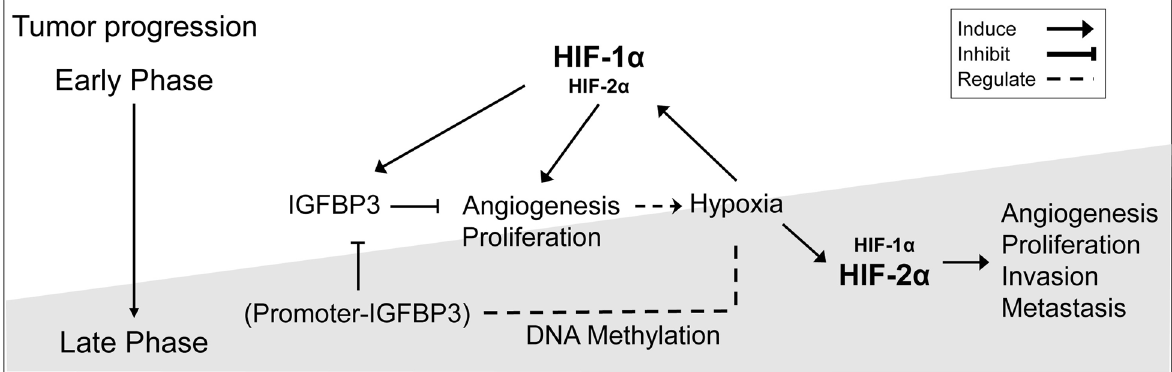
Figure 7. Clinical roles of HIF-1α and HIF-2α related to IGFBP3 expression in EOC. In an early stage of EOC, IGFBP3 expresses and inhibits proliferation and angiogenesis. The lack of blood vessels causes tumors to enter a hypoxic state, which stimulates cells to activate HIFs. HIF-1α is the major HIFs in this tumor stage. HIF-1α stimulates angiogenesis, proliferation, and induces IGFBP3 synthesis. The continuous expression of IGFBP3 prolongs the hypoxic state of the tumors by inhibiting tumor vasculogenesis. Prolonged hypoxia causes the promoter to be methylated and silence the expression of IGFBP3. As IGFBP3 decreases, the cells begin to proliferate and switch to activate HIF-2α majorly under hypoxic conditions. HIF-2α plays a significant role in cancer aggressiveness by regulating angiogenesis, invasion, and metastasis. Henceforth, the cancer cells mainly express HIF-2α under hypoxic stress. The decrease in IGFBP3 and the activation of HIF-2α instead of HIF-1α accelerate the progression in EOC. PowerPoint 2016 and Photoshop CS2 version 9 were used to generate